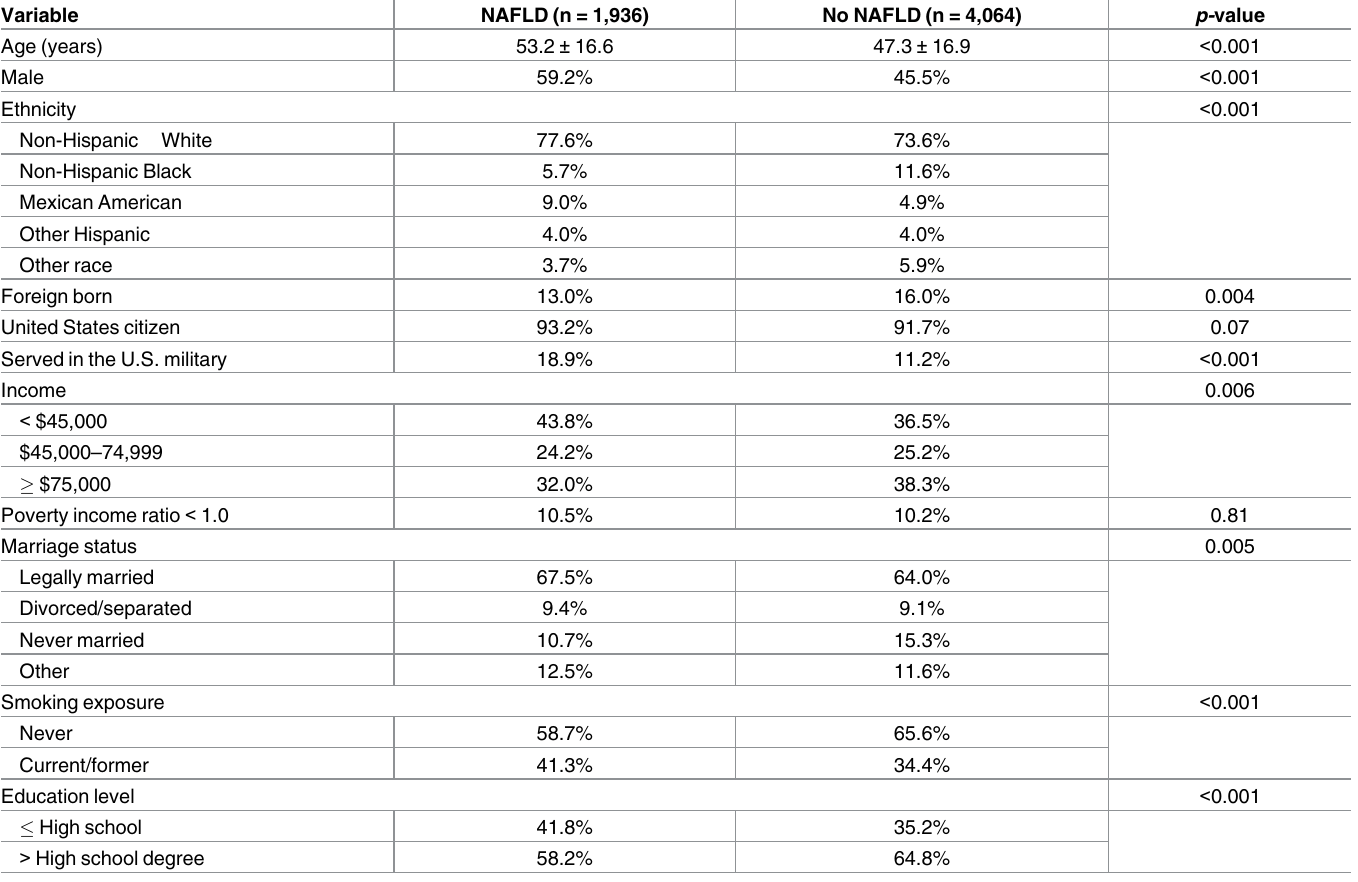
Table 1. Demographic characteristics of participants by NAFLD status in the U.S. National Health and Nutrition Examination Survey, 1999–2012. Variable NAFLD (n =